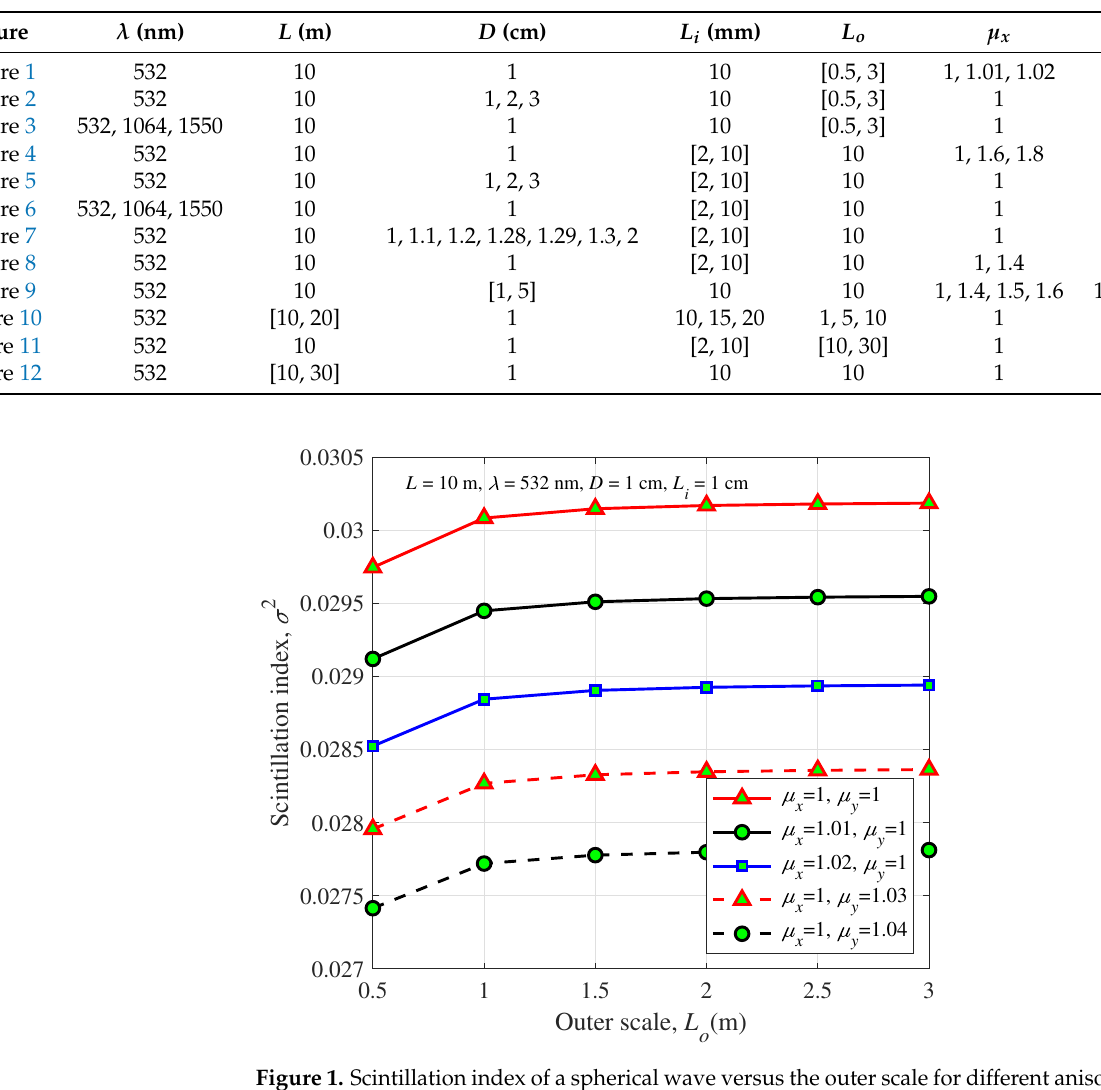
Figure 1. Scintillation index of a spherical wave versus the outer scale for different anisotropic